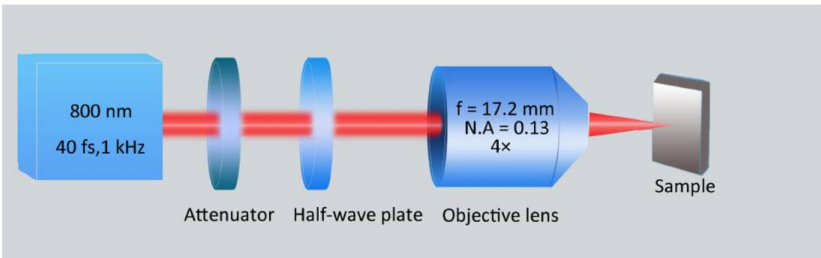
Figure 1. A schematic experimental setup for the formation of slantwise-oriented ripple structures on chromium surface by femtosecond laser